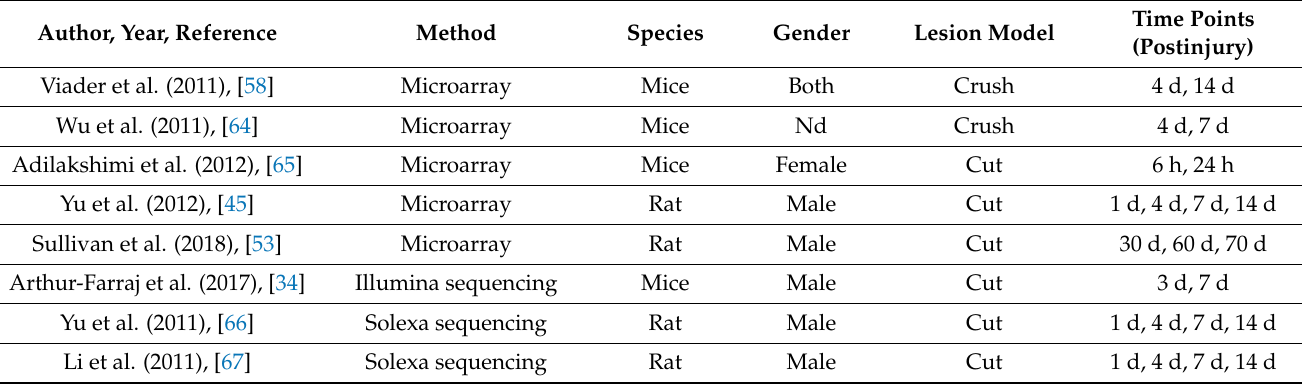
Table 2. Results for miRNA-expression profiles of miRNAs upon nerve